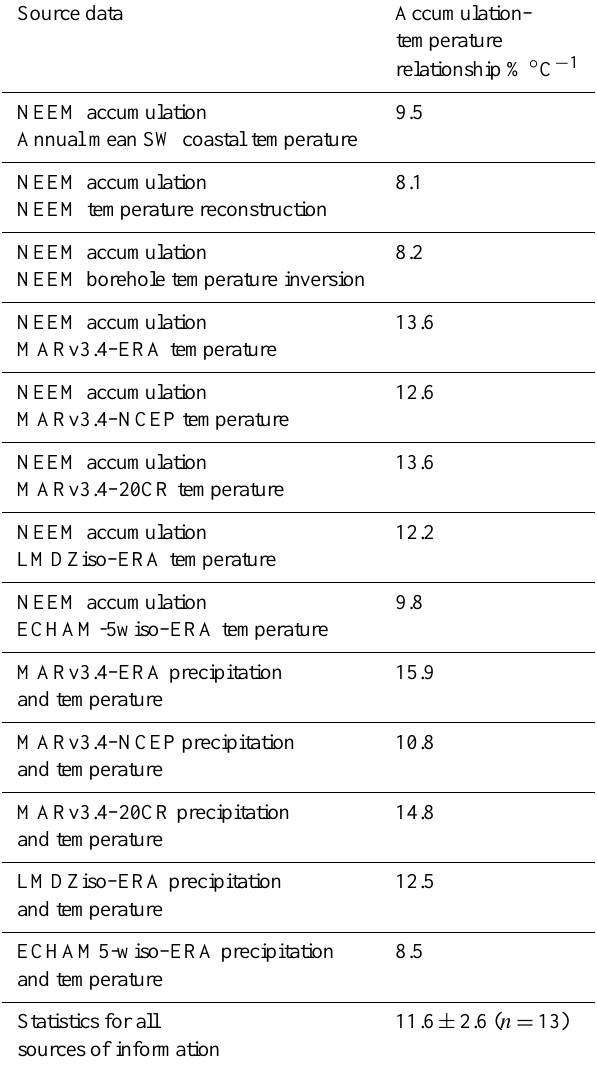
Table 7. Calculations of NEEM accumulation–surface-air- temperature relationship for the period 1979–2007 using all sources of information.